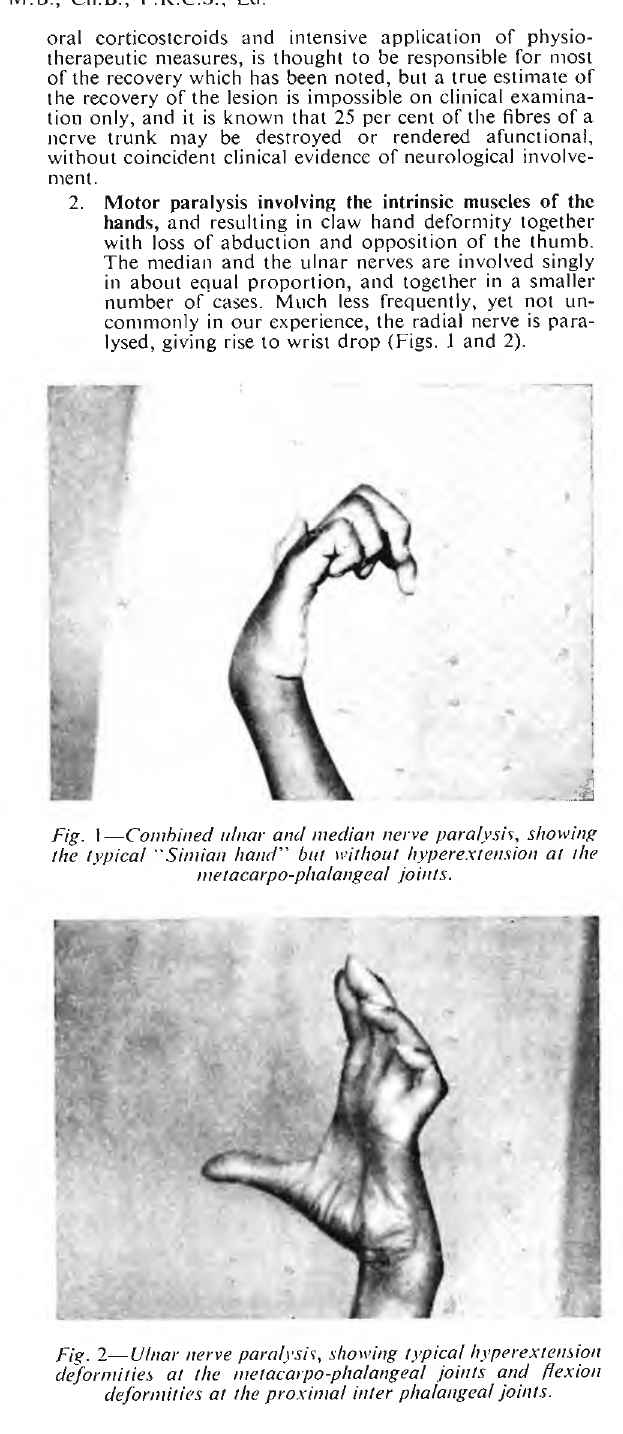
Fig. 2 — Ulnar nerve paralysis , showing typical hyperextension deformities at the metacarpo-phalangeal joints and flexion deformities at the proximal inter phalangeal